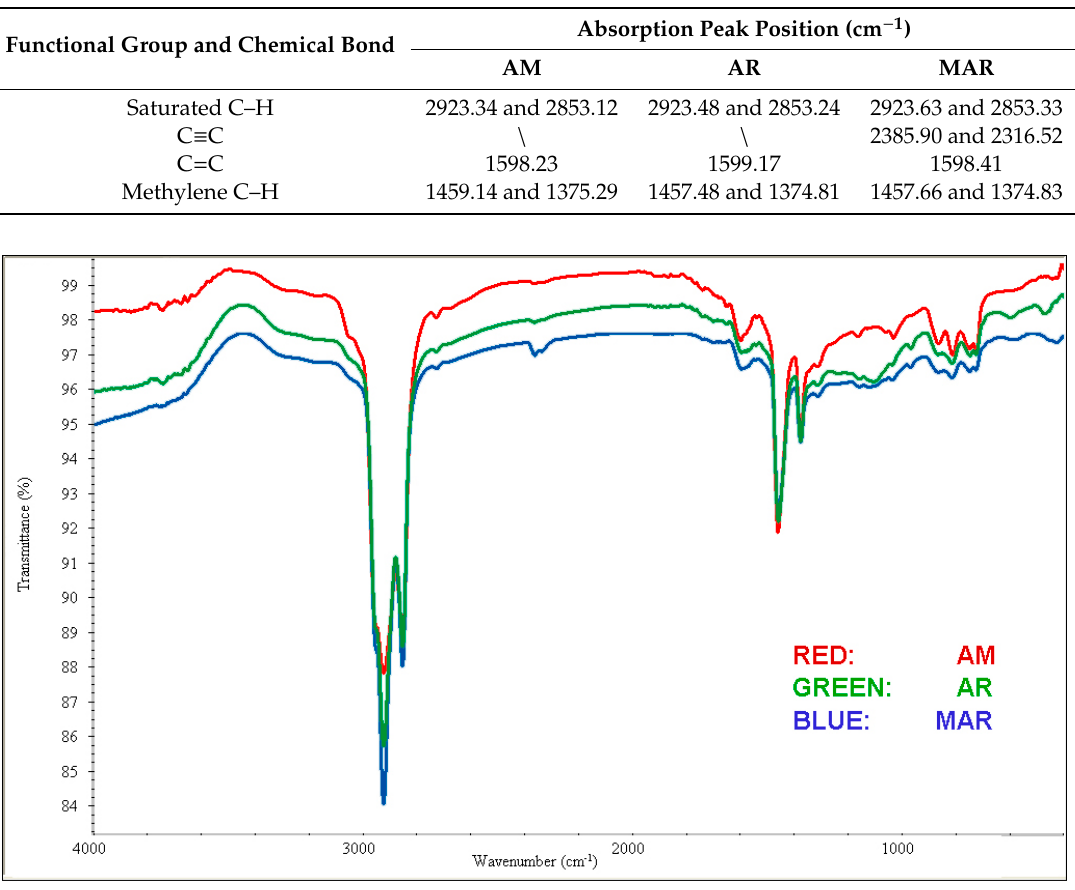
Figure 4. FTIR test result of AM, AR, and